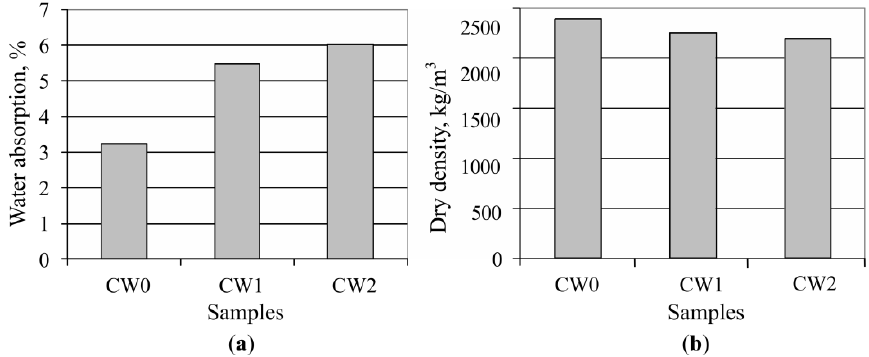
Figure 11. Concrete sample properties, ( a ) sample absorption; ( b ) sample density.